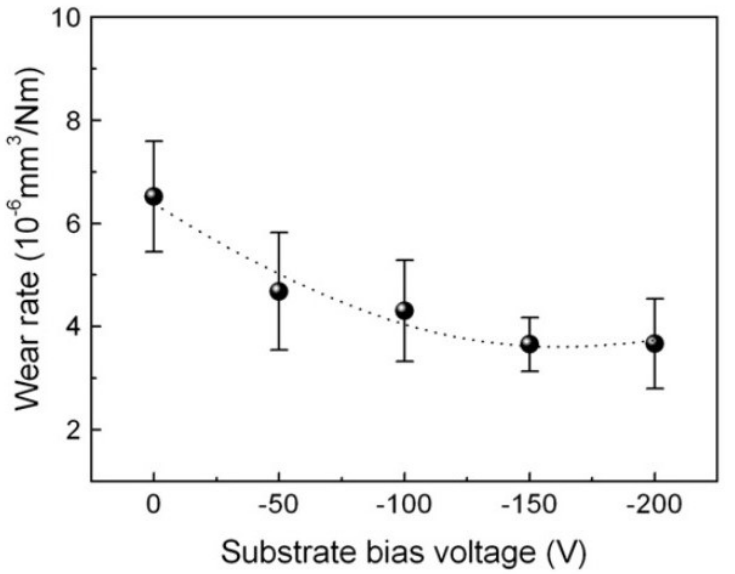
Figure 12. The wear rates of the (AlCrTaTiZr)N thin films at varying substrate bias voltages. Repro- duced with permission from [45]. Copyright 2008, Elsevier.